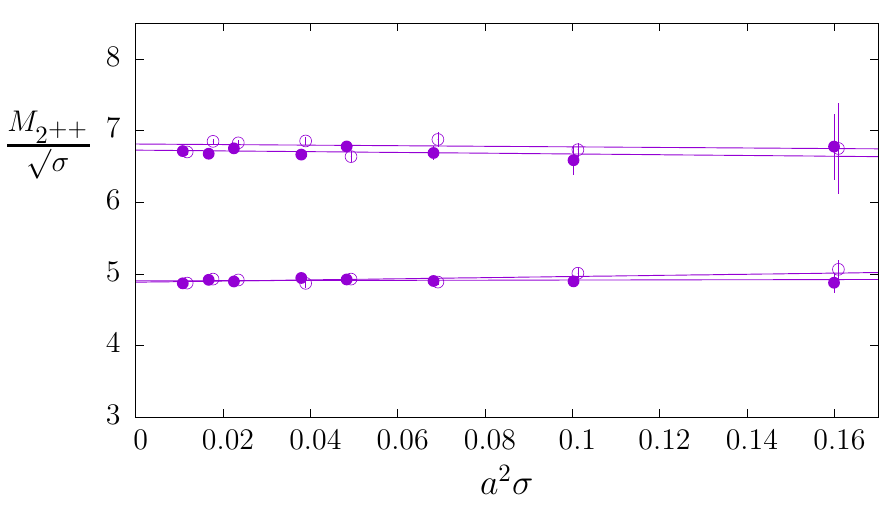
Figure 13 . Continuum extrapolations of the lightest two J PC = 2 ++ glueballs, as obtained from the lightest two E ++ states ( • , each doubly degenerate) and the lightest two T 2 ++ states ( ◦ , each triply degenerate). Hence the five components of each of the two J = 2 states.